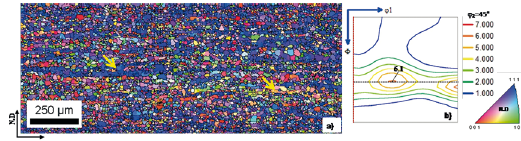
Figure 3. Microstructure and texture after annealing: a) orientation map; b) ϕ =45° ODF 2